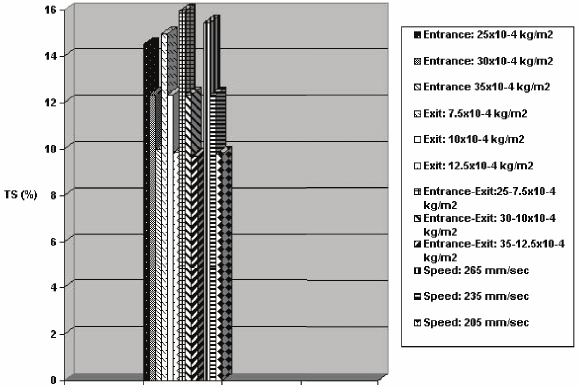
Figure 5. Effects of entrance and exit pressures and feeding speed on the thickness